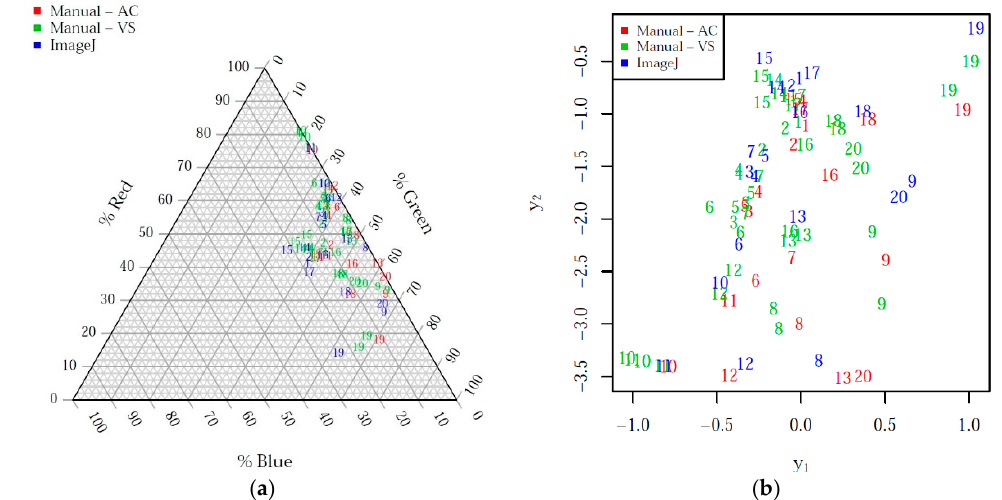
Figure 3. Scatterplot of the measurements before ( a ) and after ( b ) the isometric log ratio (ILR) transformation, labeled by image and colored by observer and method. Table 1. Summary (mean and 95% Student’s t confidence interval for the mean) of the isometric log ratio (ILR)-transformed data.